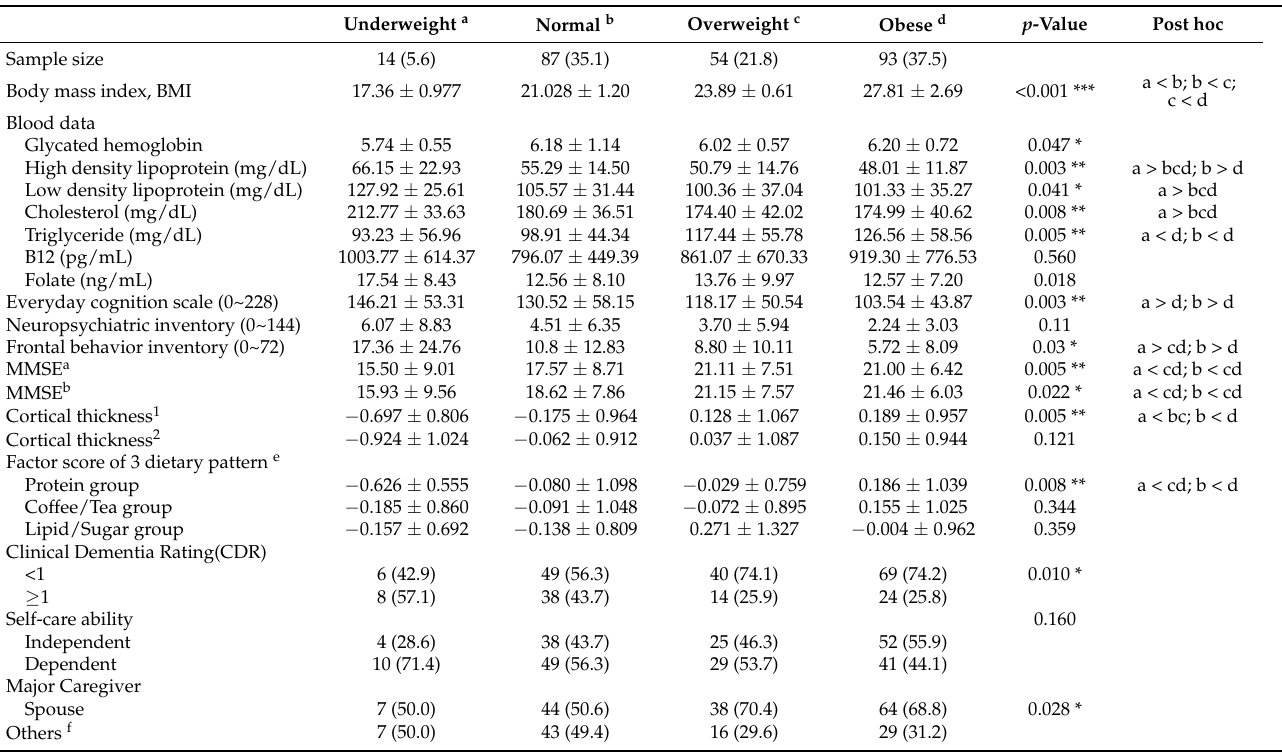
Table 3. Sociodemographic characteristics of the patients by BMI. Underweight a Normal b Overweight c Obese d p -Value Post